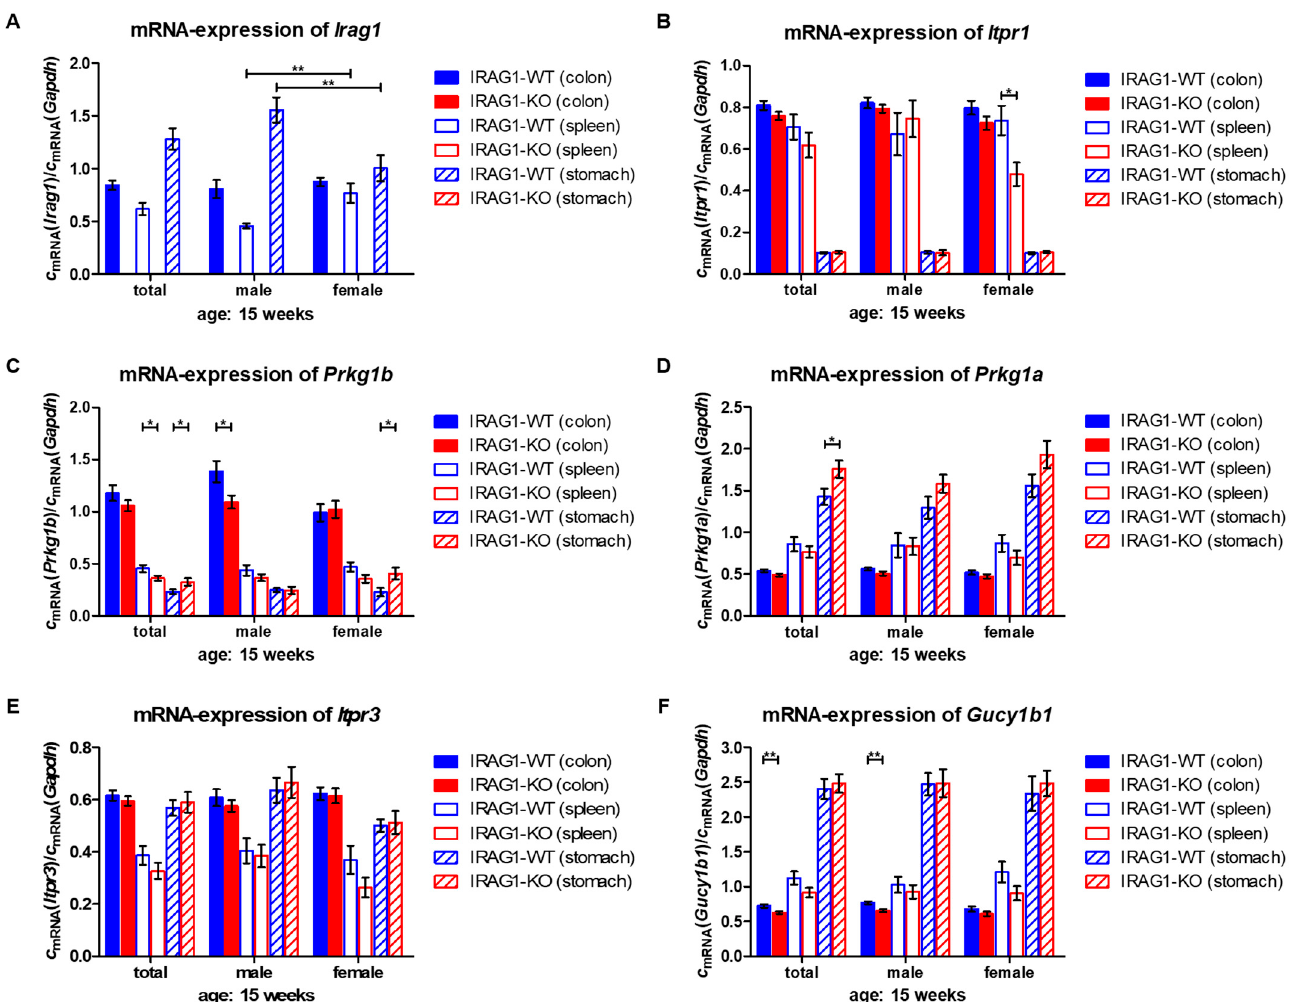
Figure 8. mRNA expression of several cGMP/PKGI-signaling genes from IRAG1-WT and IRAG1-KO mice. mRNA levels of relevant cGMP/PKGI-signaling genes were analyzed in colon, spleen and stomach of IRAG1-WT and IRAG1-KO mice (respective age: 15 weeks). ( A ) Irag1 mRNA was not found in IRAG1-KO mice (colon: total: n = 24, male: n = 12, female: n = 12; spleen: total: n = 23, male: n = 12, female: n = 11; stomach: total: n = 24, male: n = 12, female: n = 12). Differed mRNA expression of Irag1 in spleens and stomachs between male and female of IRAG1-WT mice (colon: total: n = 23, male: n = 11, female: n = 12; spleen: total: n = 23, male: n = 11, female: n = 12; stomach: total: n = 24, male: n = 12, female: n = 12). ( B ) No differences were found in mRNA levels of Itpr1 in colon and stomach (IRAG1-WT: colon: total: n = 23, male: n = 11, female: n = 12; stomach: total: n = 24, male: n = 12, female: n = 12; IRAG1-KO: total: n = 24; male: n = 12; female: n = 12; stomach: total: n = 24, male: n = 12, female: n = 12). Spleens of IRAG1-KO mice (total: n = 23, male: n = 12, female: n = 11) showed a reduction compared to the WT littermates (total: n = 23, male: n = 11, female: n = 12). ( C ) Diminished expression of Prkg1b mRNA in colon and spleen of IRAG1-KO mice (colon: total: n = 24, male: n = 12, female: n = 12; spleen: total: n = 23, male: n = 12, female: n = 11) in relation to IRAG1-WT mice (colon: total: n = 23, male: n = 11, female: n = 12; spleen: total: n = 23, male: n = 11, female: n = 12). In stomachs of IRAG1-KO mice (total: n = 24, male: n = 12, female: n = 12), Prkg1b mRNA was slightly increased compared to IRAG1-WT mice (total: n = 24, male: n = 12, female: n = 12). ( D ) mRNA of Prkg1a was not influenced by the loss of IRAG1 in colon (IRAG1-WT: total: n = 23, male: n = 11, female: n = 12; IRAG1-KO: total: n = 23, male: n = 12, female: n = 11) and spleen (IRAG1-WT: total: n = 23, male: n = 11, female: n = 12; IRAG1-KO: total: n = 23, male: n = 12, female: n = 11). In stomachs of IRAG1-KO mice, a slight increase was detected (IRAG1-WT: total: n = 24, male: n = 12, female: n = 12; IRAG1-KO: total: n = 22, male: n = 12, female: n = 12). ( E ) Expression of Itpr3 mRNA was changed by the loss of IRAG1 in the investigated tissues (IRAG1-WT: colon: total: n = 23, male: n = 11, female: n = 12; spleen: total: n = 23, male: n = 11, female: n = 12; stomach: total: n = 24, male: n = 12, female: n = 12; IRAG1-KO: total: n = 24, male: n = 12, female: n = 12; spleen: total: n = 23, male: n = 12, female: n = 11; stomach: total: n = 24, male: n = 12, female: n = 12). ( F ) mRNA levels of Gucy1b1 were not different between IRAG1-WT mice (IRAG1-WT: colon: total: n = 23, male: n = 11, female: n = 12; spleen: total: n = 23, male: n = 11, female: n = 12; stomach: total: n = 24, male: n = 12, female: n = 12) and IRAG1-KO mice (total: n = 24, male: n = 12, female: n = 12; spleen: total: n = 23, male: n = 12, female: n = 11; stomach: total: n = 24, male: